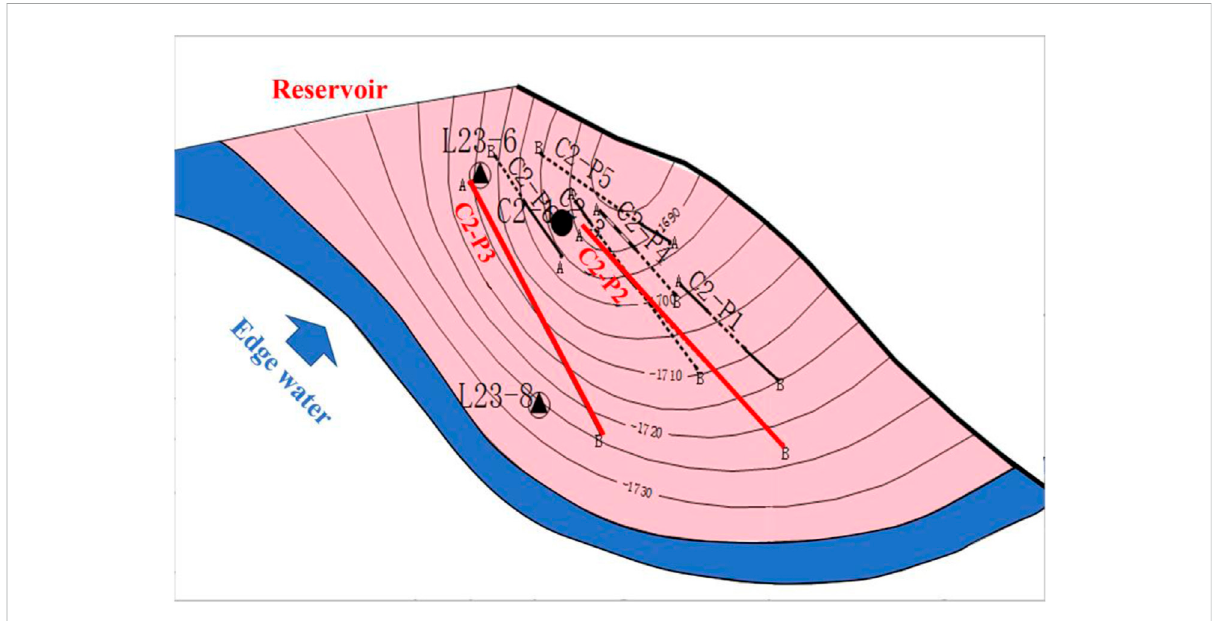
FIGURE 1 Top structure map of C2-1 Block, Jidong Oil fi eld,